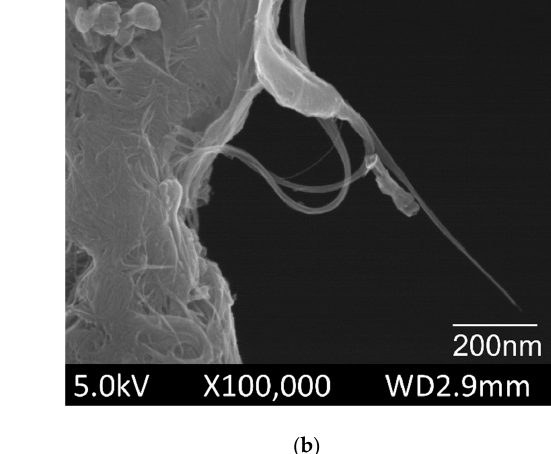
Figure 2. Schematic representation of the experimental gas sensor testing setup.